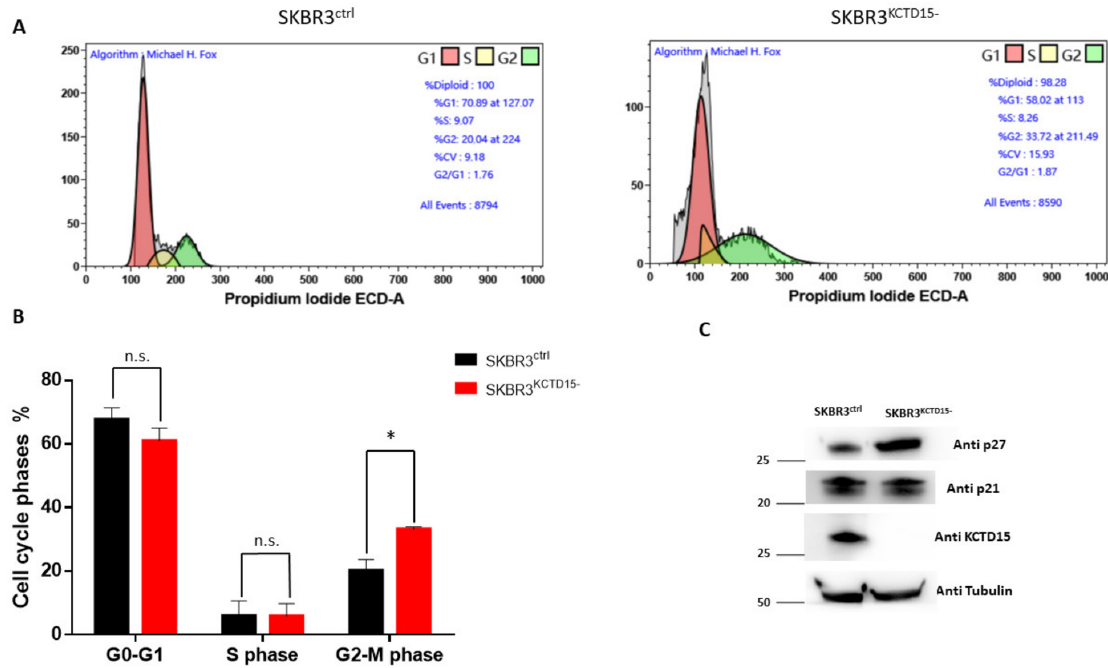
Figure 5. KCTD15 silencing causes the G2 m alteration of the SKBR3 cell cycle. ( A ) Flow cytometry analysis of the cell cycle distribution in SKBR3 ctrl ( left ) and SKBR3 KCTD15 − ( right ) cells after 72 h